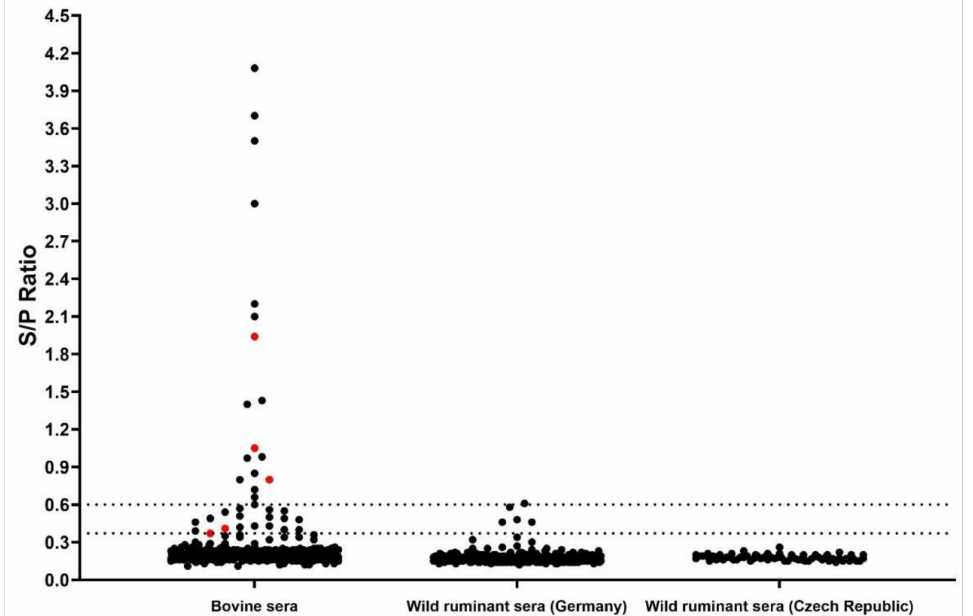
Figure 4. Serological screening of ruminant serum samples through LIPS. Samples are represented by black dots and included bovine sera from Bulgaria ( n = 360) and wild ruminant sera from Germany ( n = 215) and the Czech Republic ( n = 67). The dashed lines represent the cut off values to define negative, moderately and highly reactive samples. Serologically reactive samples positive for BovHepV RNA are marked in